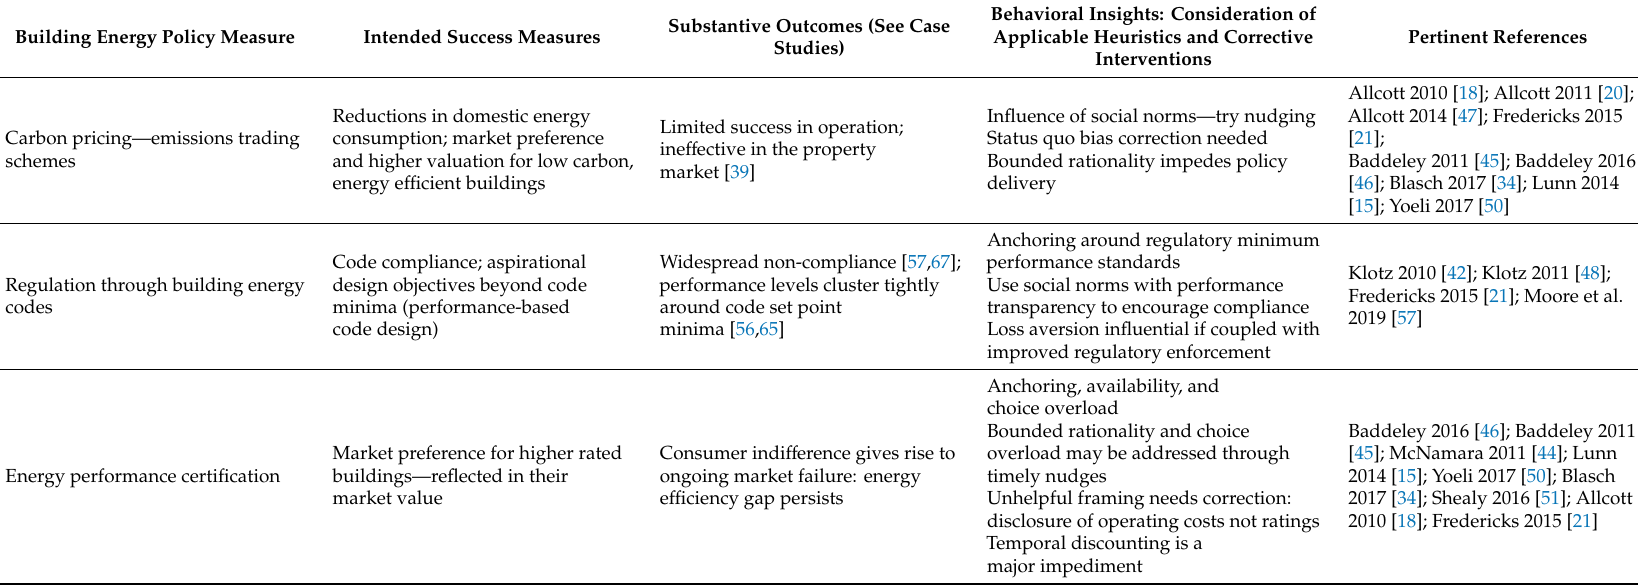
Table 4. Application of BE measures to correct shortcomings in market interventions, as demonstrated in preceding case